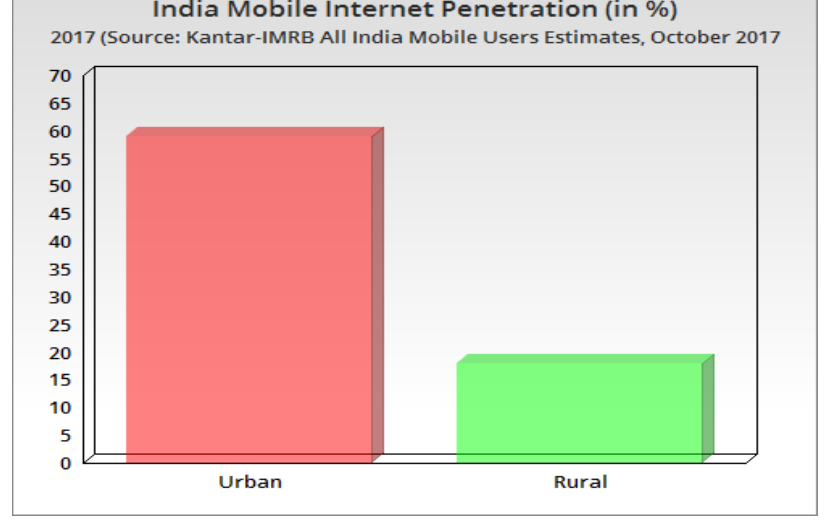
Figure 1. India mobile Internet penetration as a